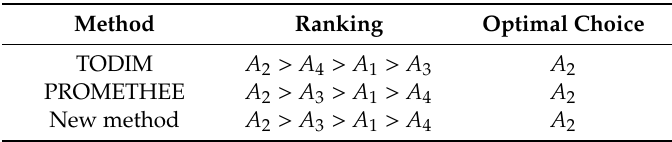
Table 5. Ranking of